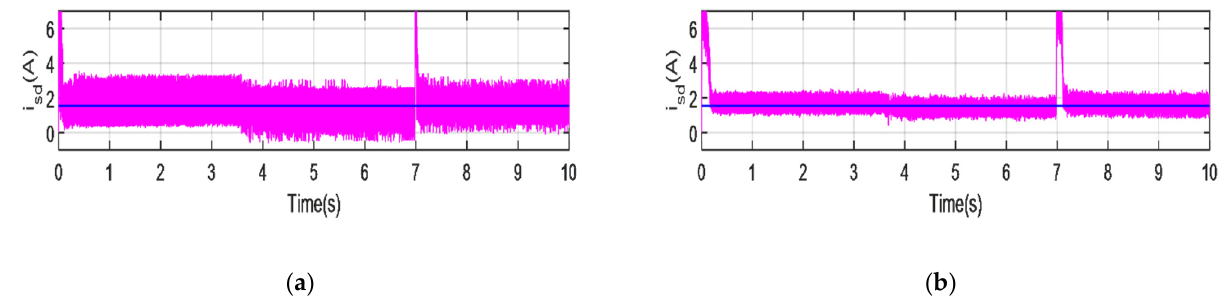
Figure 23. Isd components: ( a ) conventional inverter; ( b ) five-level inverter.